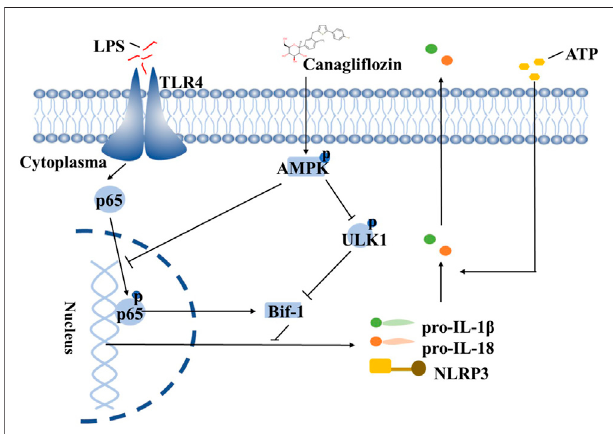
FIGURE 6 | Schematic depicting that CAN ameliorates NLRP3 in fl ammasome-mediated in fl ammation through inhibiting NF- κ B signalingandup-regulatingBif-1.ThestructureofCANcomesfromDrugBank (https://go.drugbank.com/drugs/DB08907).